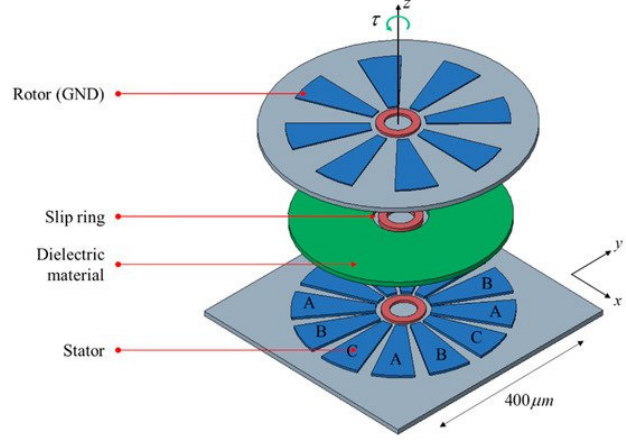
Figure 14. Top-drive electrostatic rotary actuator with a ring-shaped bearing. Adapted from [100].